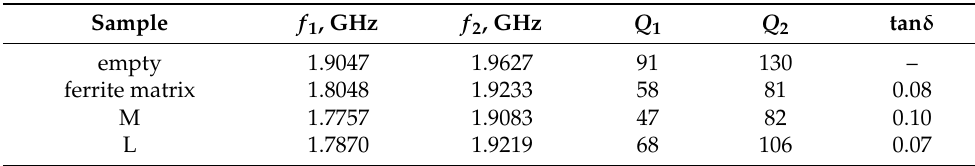
Table 2. Microwave parameter